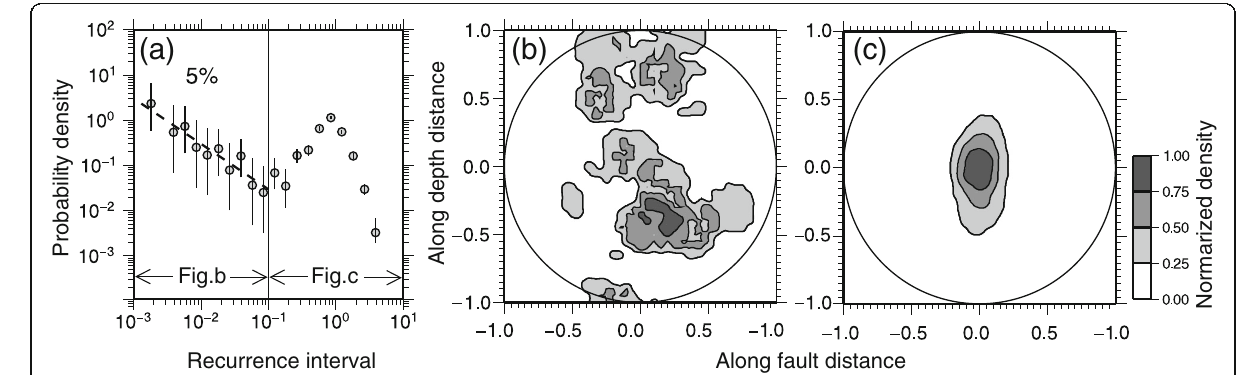
Fig. 7 Behavior of repeater candidates dependent on recurrence intervals. a Probability density for normalized recurrence intervals. The normalized recurrence intervals are defined by the interval divided by the averaged recurrence interval for sequences with four or more earthquakes. The dashed line shows a power law decay. b , c Spatial distribution for b short-term (normalized recurrence intervals < 0.1) and c long-term (normalized recurrence intervals > 0.1) earthquakes in a repeating sequence compared to the centroid of the sequence. After Lengliné and Marsan